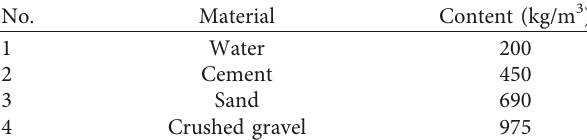
Table 1: Ingredients of the concrete